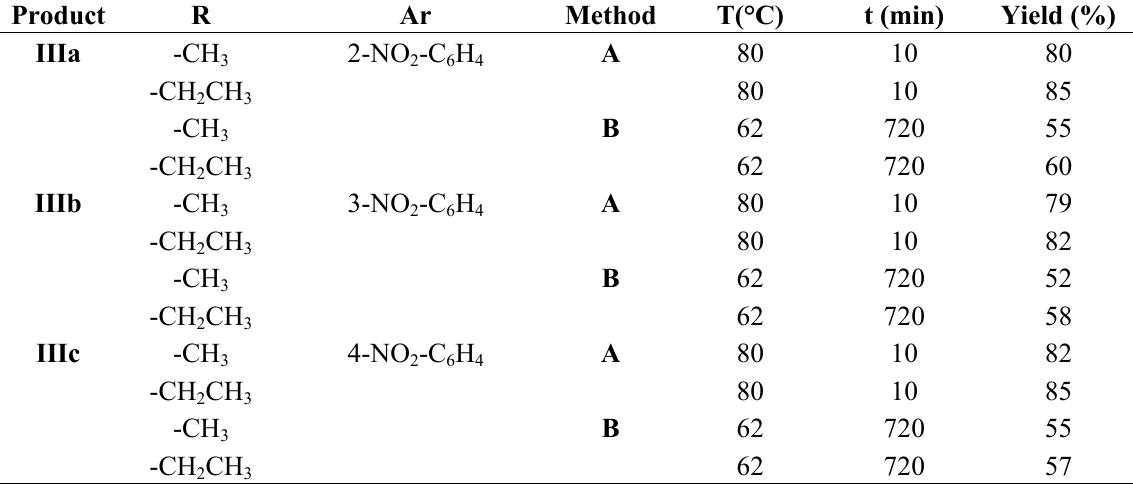
Table 2. Results of MWASwithout solvent (Method A) of